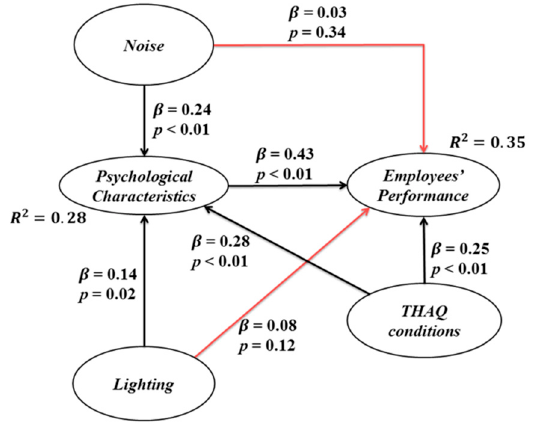
Figure 2. Direct effects.